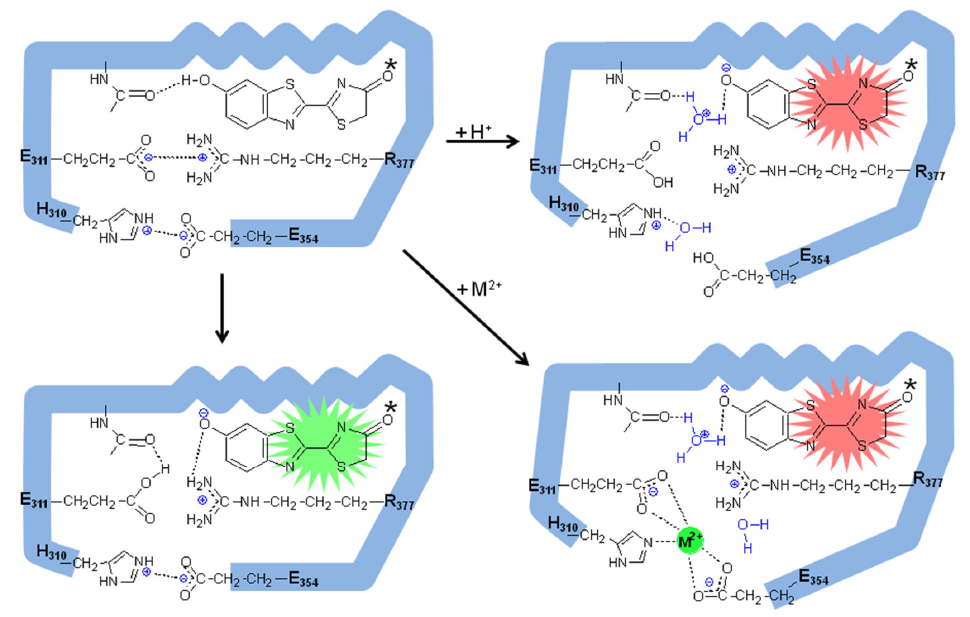
Figure 5. The proposed mechanism of pH and metal sensitivity in firefly luciferases involves the oxyluciferin phenol/phenolate group excited state proton transfer and electrostatic interactions between residues E311 and R337, and H310 and E354, which keep the active site closed. Whereas the keto form of excited oxyluciferin was considered the most likely emitter in this figure for simplicity, the process of keto-enol tautomerization in bioluminescence color determination can not be ruled out. Reprinted from ref. [31].